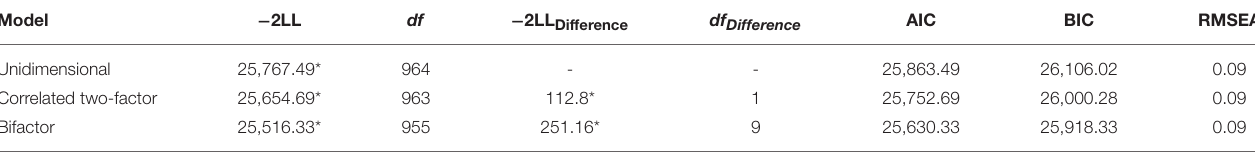
TABLE 4 | Fit statistics of IRT models.